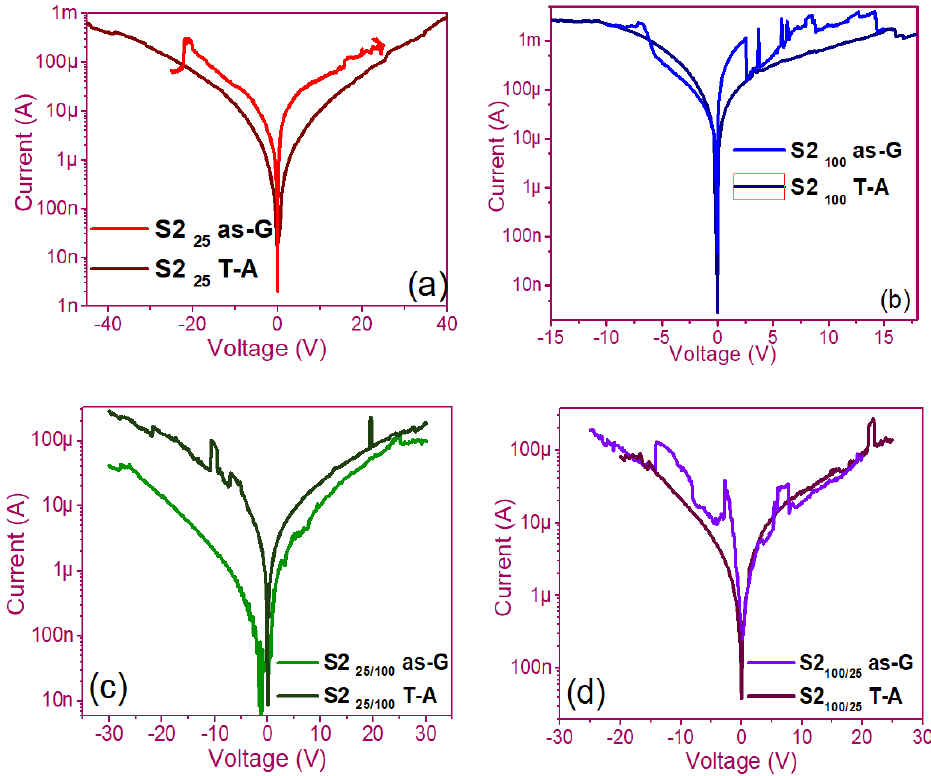
Figure 6. I-V curves ( a ) S2 25 as-G and T-A, ( b ) S2 100 as-G and T-A, ( c ) S2 25/100 as-G and T-A, ( d ) S2 100/25 as-G and T-A.